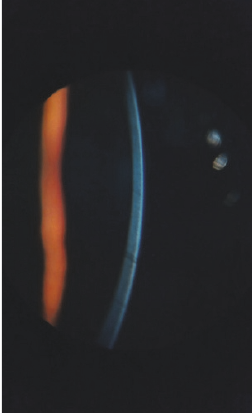
Figure 17: Slit view of the cornea through eyeSmart